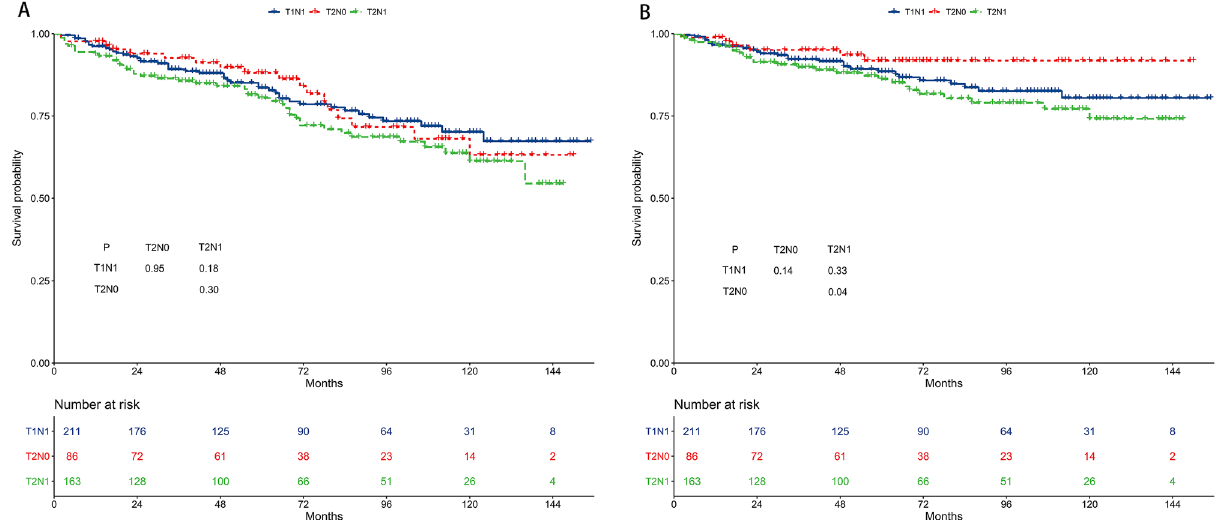
Figure 8. Survival outcomes of the T1N1, T2N0, and T2N1 subgroups in the WHO II/III group. ( A ) Overall survival. ( B ) Cancer-specific